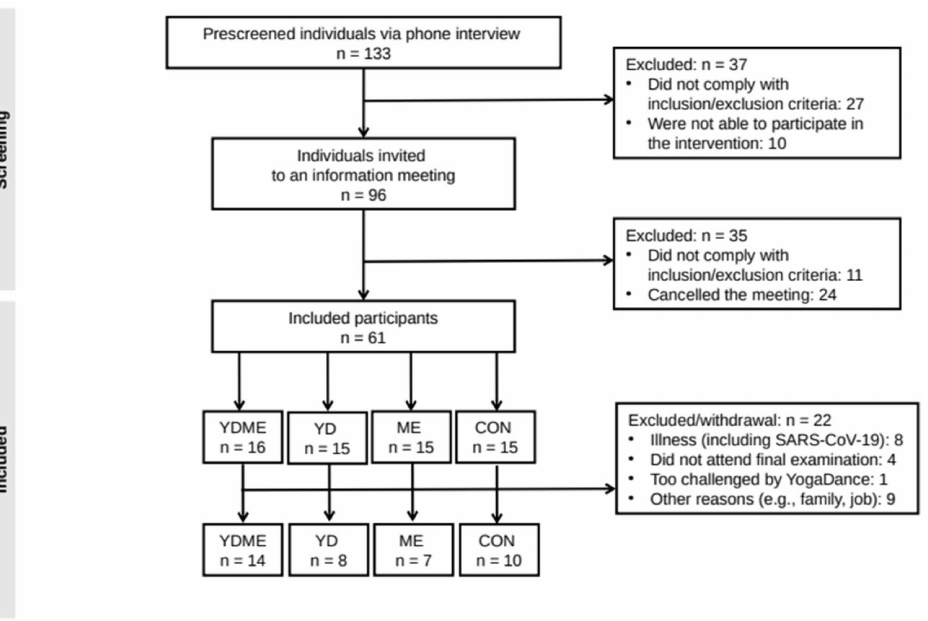
Figure 1. Flow chart of the study. CON = control, ME = mindful eating, YD = YogaDance, YDME = mindful eating and YogaDance combined. Table 1. Baseline participant characteristics stratified according to intervention